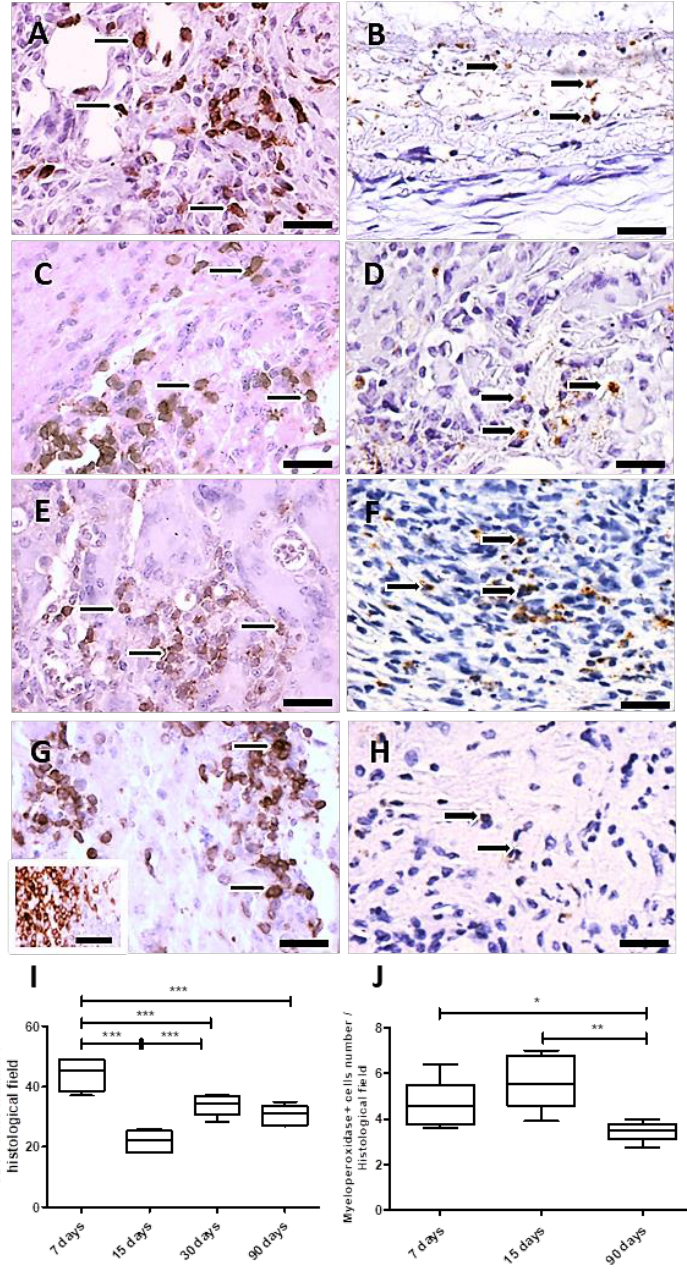
Figure 5. Immunohistochemistry and quantification of CD3 and myeloperoxidase positive cells. Detail of histological sections of PLGA-induced inflammatory response containing CD3 + cells. ( A ): 7 days PI (thin arrows); ( C ): 15 days PI (thin arrows); ( E ): 30 days PI (thin arrows); ( G ): 90 days PI (thin arrows). Detail of histological sections of PLGA-induced inflammatory response containing myeloperoxidase + cells: ( B ): 7 days PI (thick arrows); ( D ): 15 days PI (thick arrows); ( F ): 30 days PI (thick arrows); ( H ): 90 days PI (thick arrows). In ( G ), inset represents the positive control of the anti-CD3 antibody, depicting CD3 + cells in human tonsil. Scale bars ( A – H ): 50 μm. ( I ): Graphical representation of the CD3 + , showing decreased numbers at 15 and 90 days PI. ( J ): Graphical representation of myeloperoxidase + cells along time showing increased number of myeloperoxidase+ cells a 15 days PI, decreasing 90 days PI. * p < 0.05, ** p < 0.01, *** p < 0.001, ns, indicates significant differences.